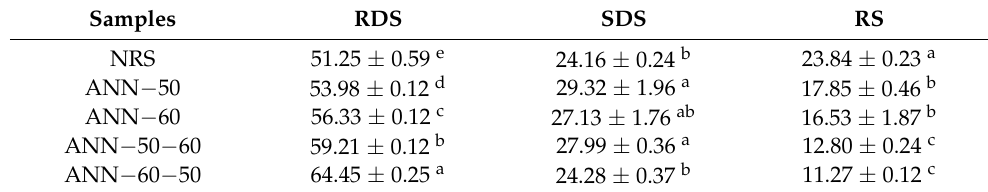
Figure 7. The digestion curve of the one and two-step annealed rice starch samples.